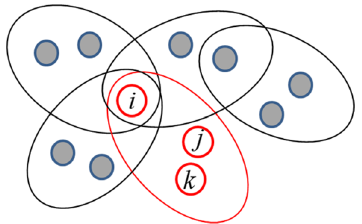
Figure 2. Multiple-group game relationships are represented by the uniform scale-free hypernetwork. The figure shows the scale of the hypernetwork N = 11 that is the total number of nodes. The node-degree of each hyperedge is equal to 3, which indicates that the hypernetwork is uniform and the nodes in each hyperedge can play a game with 2 opponents. Node i is the overlapping node with hyperdegree 4, and plays a game with 2 × 4 opponents from four hyperedges or groups. In the same hyperedge, the node plays a game with each other. For example, in the red node and hyperedge, nodes are well-mixed and nodes i, j , and k play a game with each other.